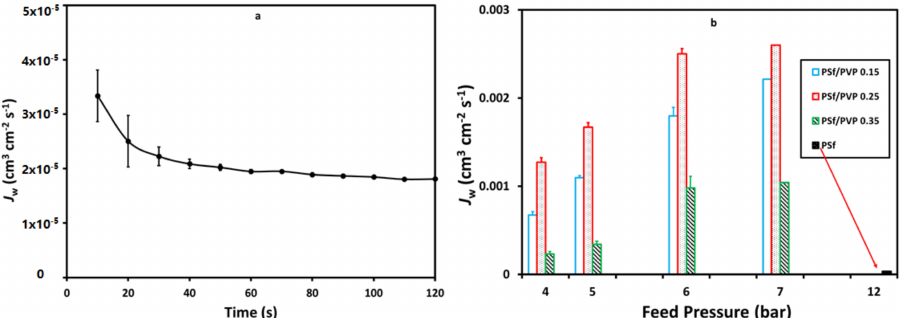
Figure 8. Profile of wastewater flux, J W , of the pristine PSf membrane at 12 bar ( a ) and the effects of feed pressure on the wastewater flux ( b ) on the membrane filtration